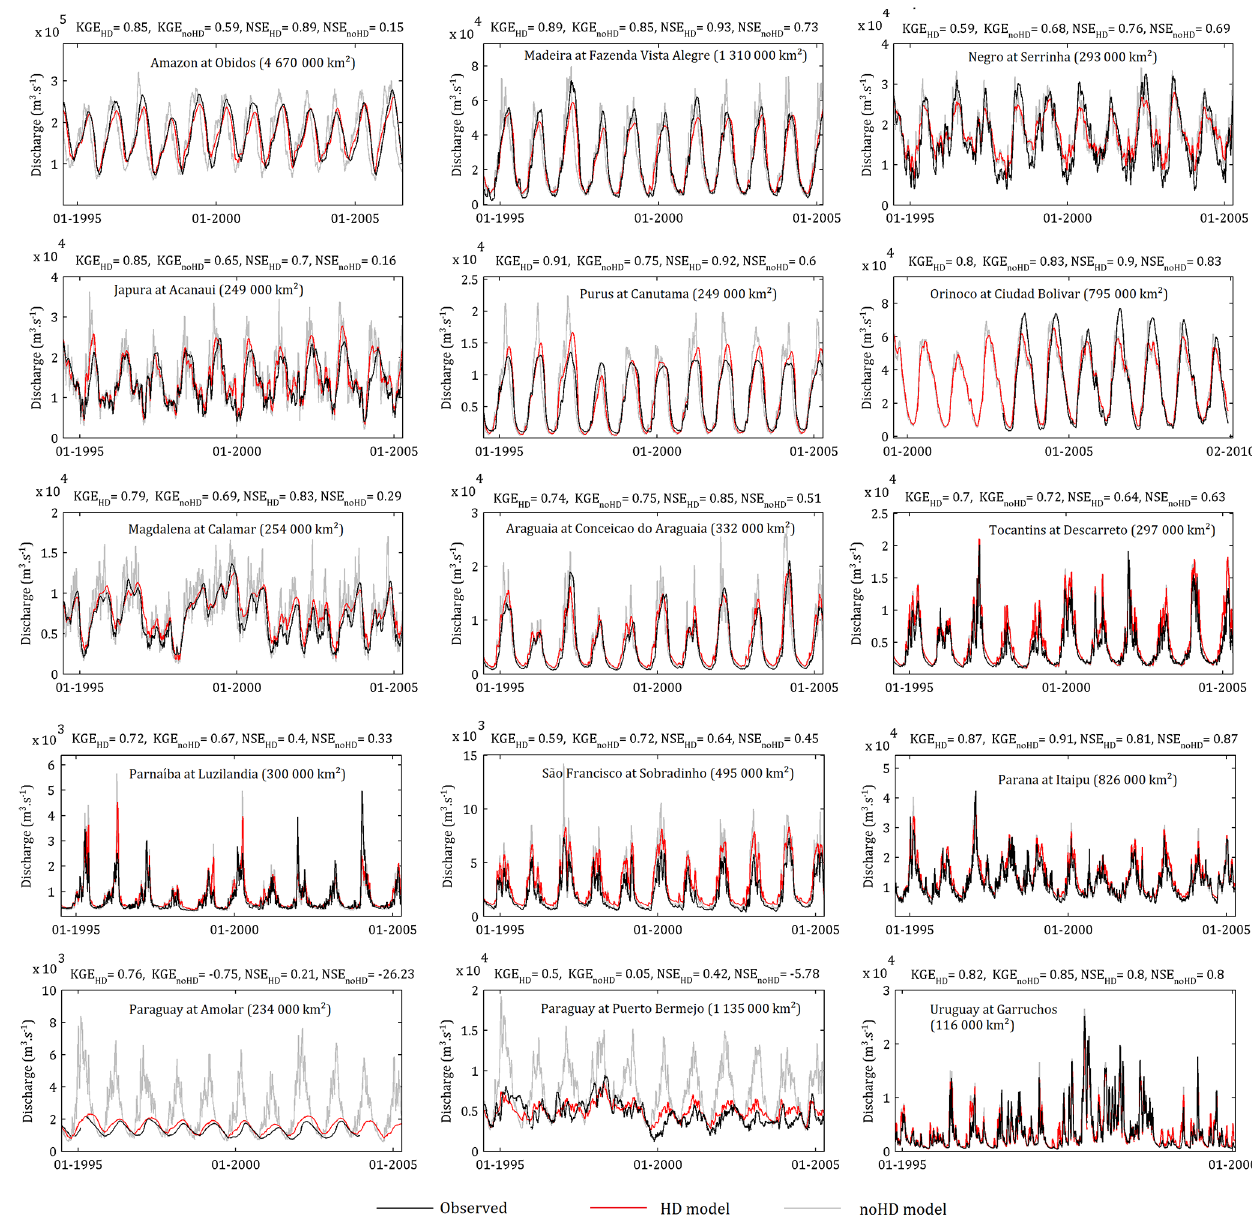
Figure 4. Comparison between observed (black) and simulated discharge for major South American rivers. Model results are shown consid- ering both hydrodynamic (HD; red color) and non-hydrodynamic (noHD; gray color) routing